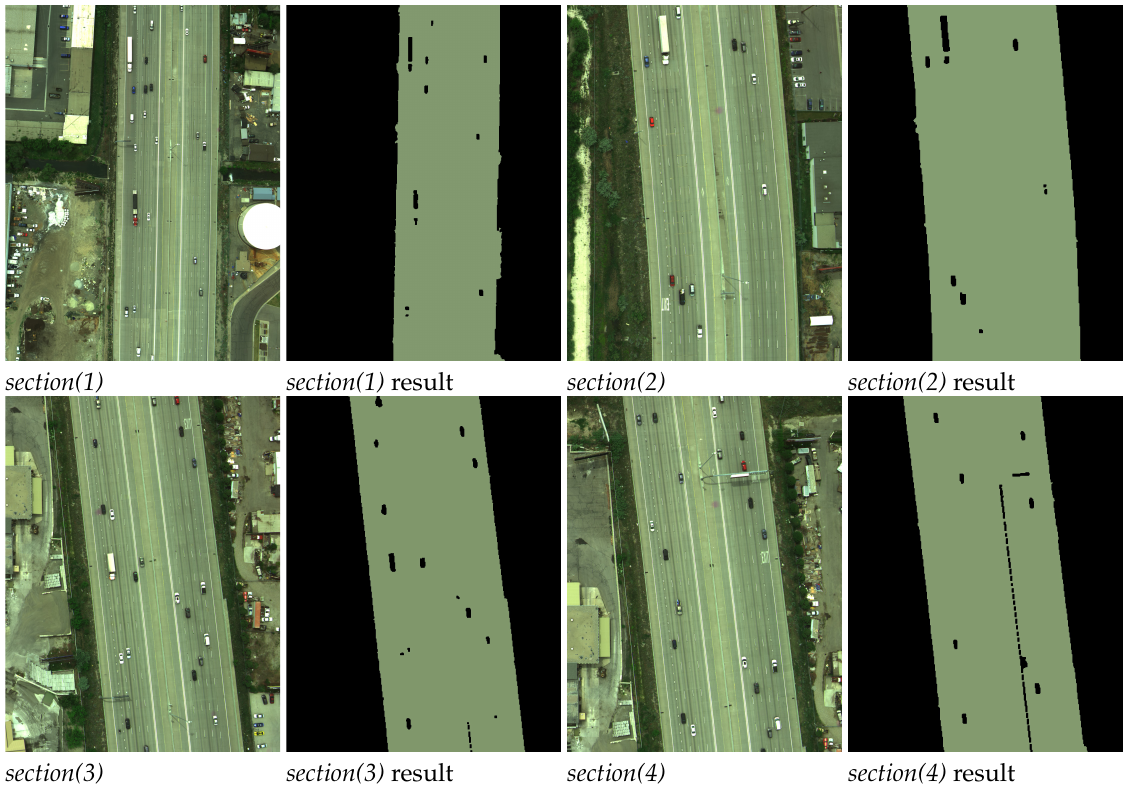
Figure 4. Road extraction results for four sections of the road, section(1) , section(2) , section(3) , and section(4)